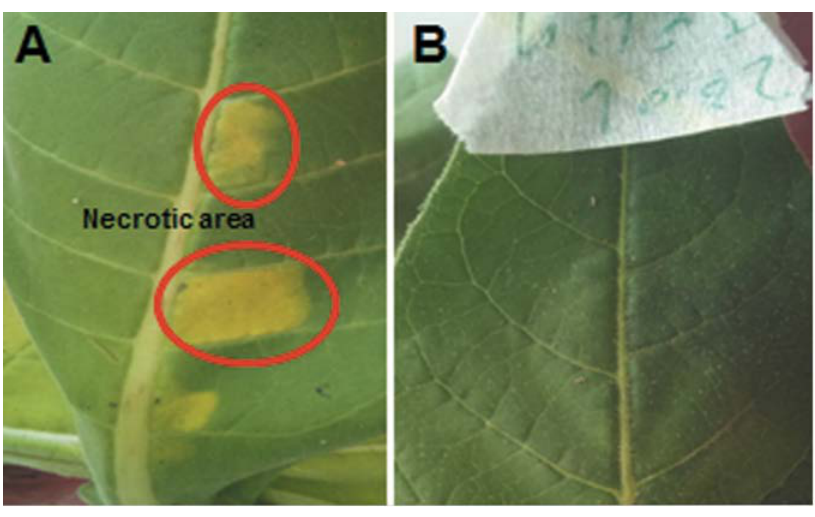
Figure 3. Yellow symptom was appeared on tobacco leaves after inoculation with Pa iso- late; A) Positive result; B) Negative result.